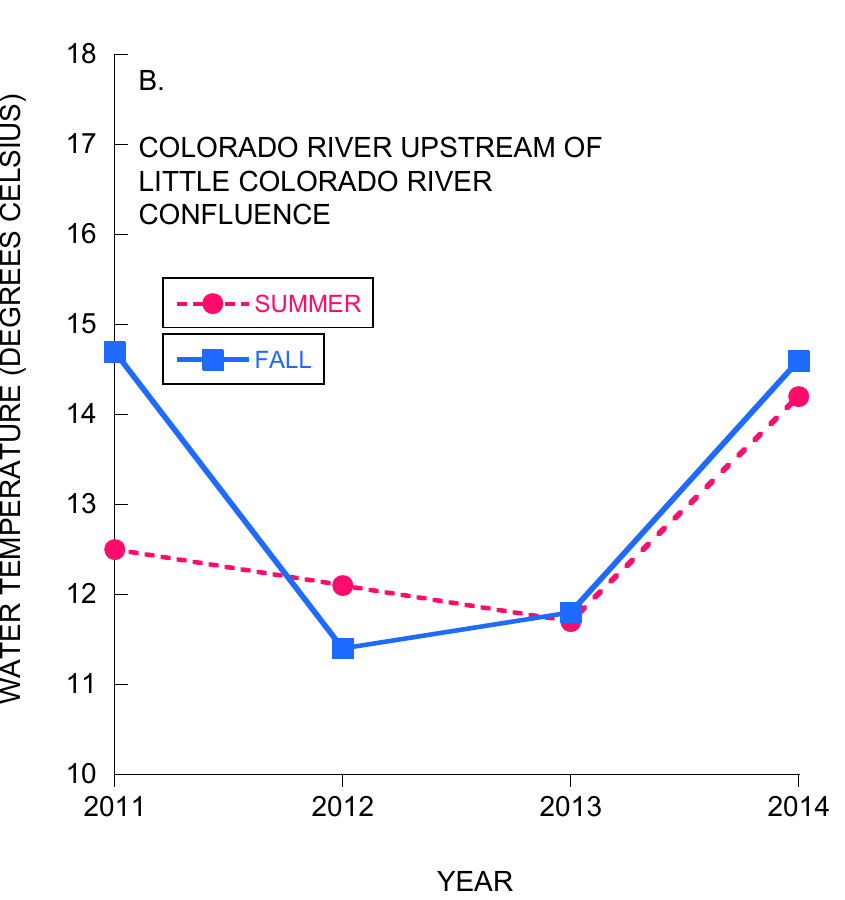
Figure A1.6. Median 2011-14 summer (June-August) and fall (September – November) water temperatures of the Colorado River measured at US Geological Survey streamgages 09380000 and 09383100, located (A) 25 km (at Lees Ferry) and (B) 122 km (near the Little Colorado River confluence) downstream of Glen Canyon Dam. (data: